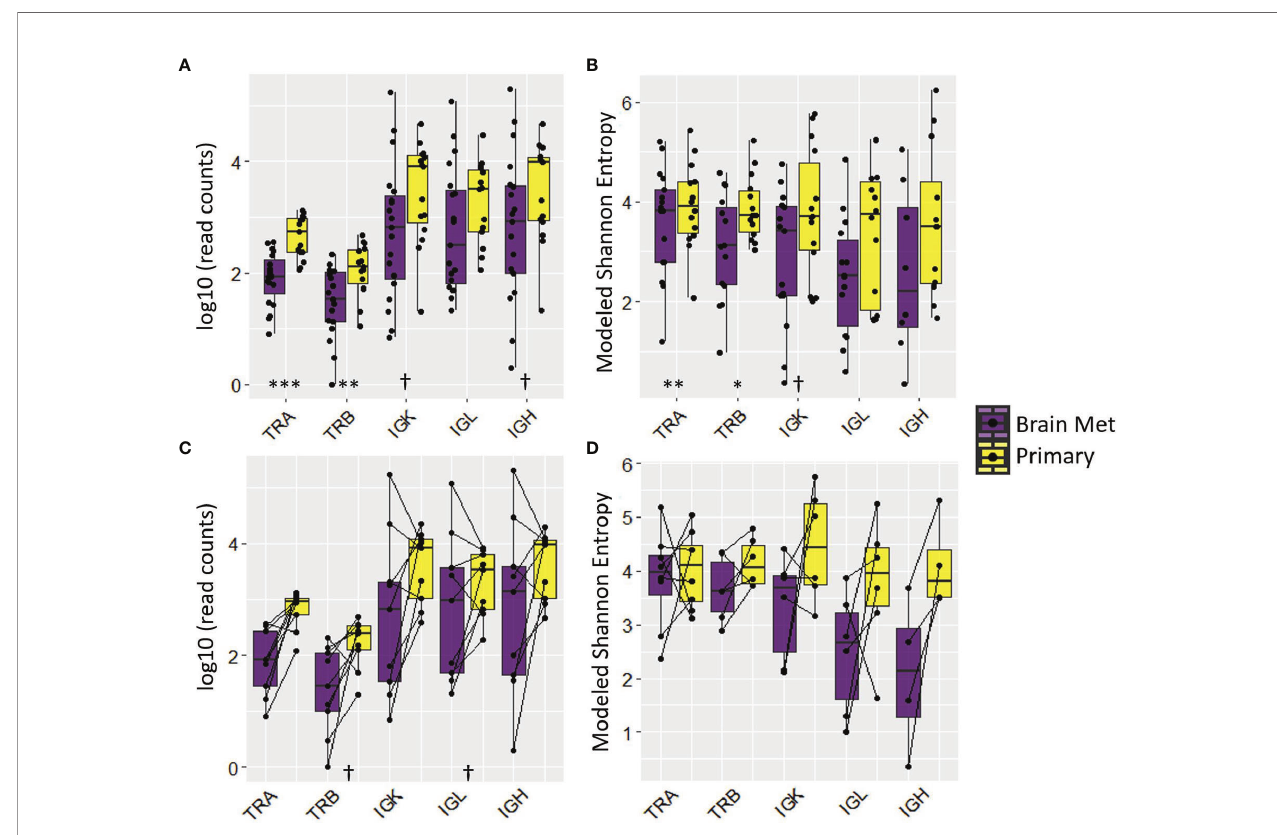
FIGURE 4 | T cell and B cell repertoire analysis revealed adaptive immune cell de fi cit in BrM relative to primary triple-negative breast cancer. The distribution of read counts and modeled Shannon entropy for all samples is displayed in (A, B) , respectively. The same information is displayed, respectively, in (C, D) for matched pairs (note that the number of matched pairs varies due to the presence/absence of relevant reads). Wilcoxon rank-sum test was performed on log 10 -transformed (read counts) or raw (modeled Shannon entropy) values to determine the statistical signi fi cance. Signi fi cance codes: † p < 0.1; * p < 0.05; ** p < 0.01; *** p <